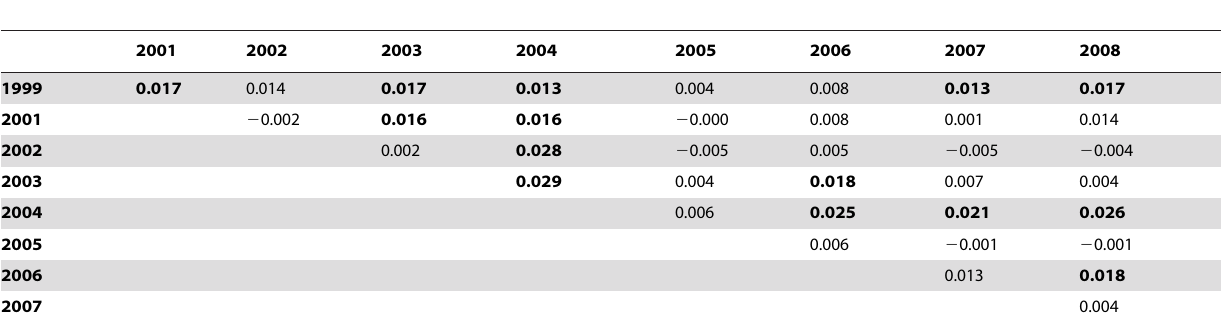
Table 3. Pairwise Fst divergence between successive cohorts of a natural invasive population of M. schimitscheki in southeastern